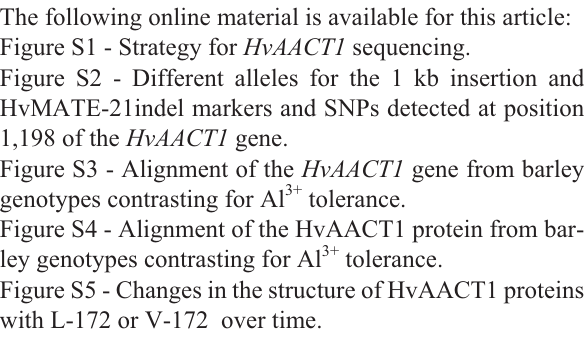
Figure S2 - Different alleles for the 1 kb insertion and HvMATE-21indel markers and SNPs detected at position 1,198 of the HvAACT1 gene. Figure S3 - Alignment of the HvAACT1 gene from barley genotypes contrasting for Al 3+ tolerance. Figure S4 - Alignment of the HvAACT1 protein from bar- ley genotypes contrasting for Al 3+ tolerance. Figure S5 - Changes in the structure of HvAACT1 proteins with L-172 or V-172 over